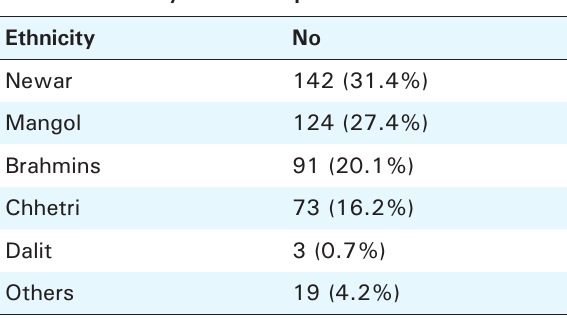
Table 1. Ethnicity of the recipients